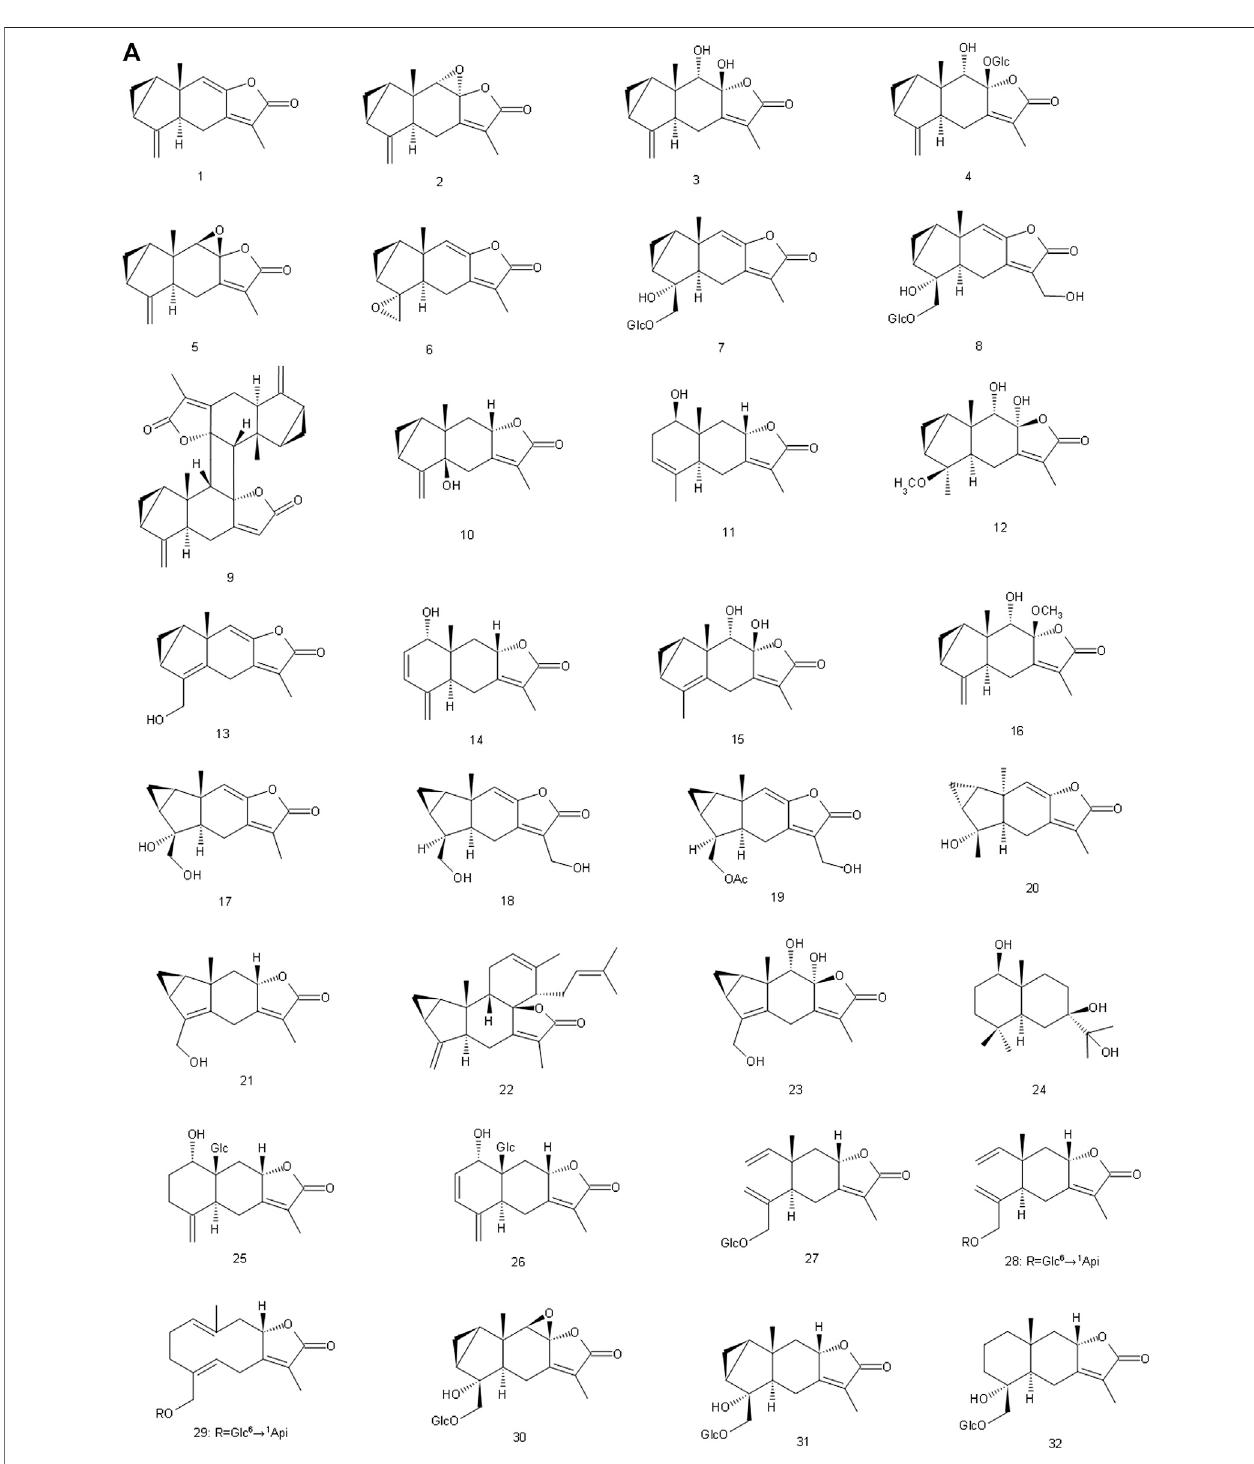
FIGURE3|(A) Chemicalstructuresofsesquiterpenes (A) identi fi edin S.glabra extract. (B) Chemicalstructuresofsesquiterpenes (A) identi fi edin S.glabra extract. (C) Chemical structures of sesquiterpenes (A) identi fi ed in S. glabra extract. (D) Chemical structures of sesquiterpenes (A) , and diterpenes (B) identi fi ed in S. glabra extract. (E) Chemical structures of triterpenes (C) identi fi ed in S. glabra extract.